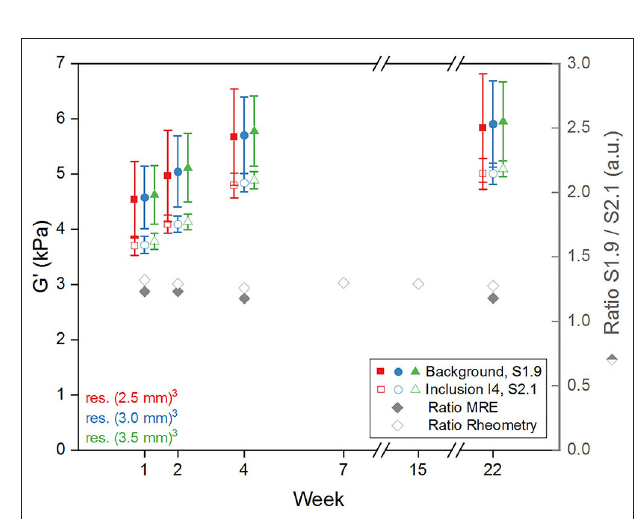
FIGURE 8 | Plot of G’ median values measured via MRE in the background (filled symbols) and in the inclusion I4 (empty symbols) vs. time post fabrication and with error bars representing the standard deviation for the three resolutions (red (2.5mm) 3 , blue (3.0mm) 3 , green (3.5mm) 3 ). Right axis: ratio of G’ between background and inclusion for 3mm resolution (gray filled diamonds) and between corresponding samples for rheometry (gray empty